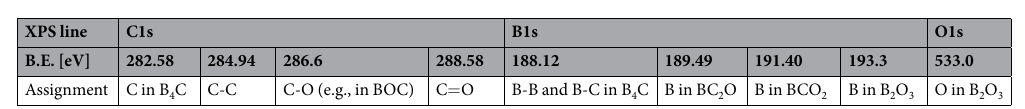
Table 2. XPS core level line assignments (“BOC” refers to boron